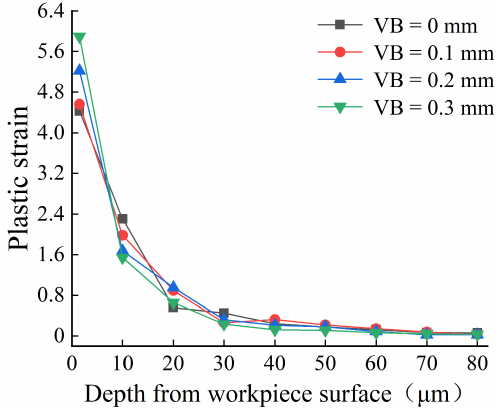
Figure 6. Plastic strain through the depth of workpiece surface.